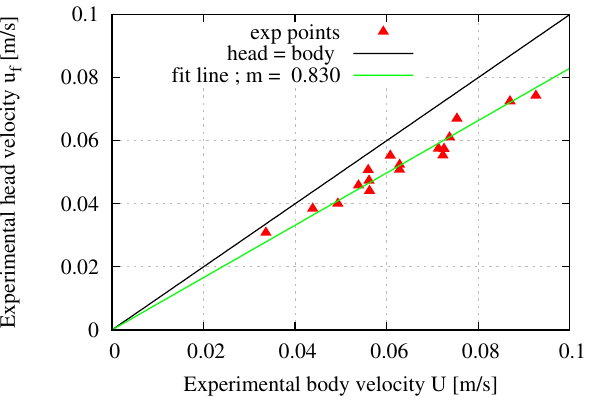
Figure 4. Comparison between the flow height computed integrat- ing the longitudinal velocity profile (red line) with di ff erent upper limit of integration (0-0.1-0.2-0.3-0.4-0.5U) and the flow interface extracted visually (blue line) from the lateral sidewall (Experiment S4 - section C5). The crosses are located at heights corresponding to the flow thickness computed employing di ff erent values of the upper bound of integration.